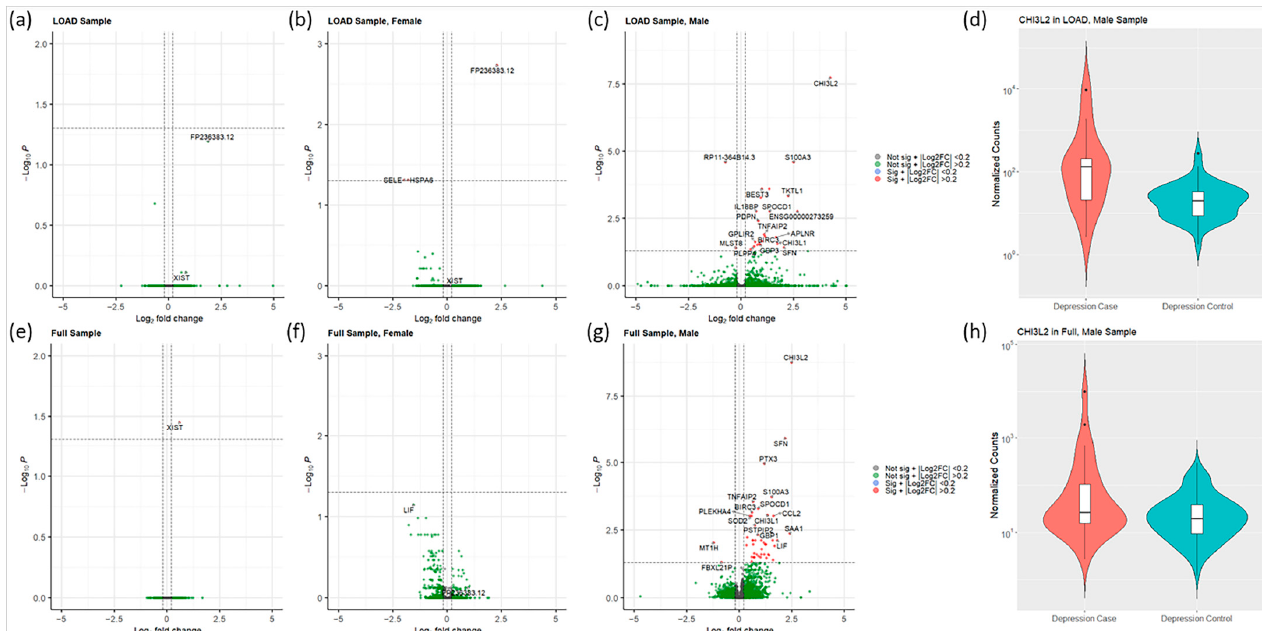
Figure 1. Differential gene expression analysis identified sex-specific expression in depression. Vol- cano plots of the ( a ) LOAD sample, ( b ) female subset of LOAD sample, and ( c ) male subset of LOAD sample. There were no DEGs in the LOAD sample, while the sex-stratified analysis detected 3 and 25 DEGs within the female and male samples, respectively. ( d ) CHI3L2 was significantly upregu- lated within the male, LOAD sample illustrated by the violin plot (log 2 FC = 4.248, p = 1.84 × 10 − 8 ). Volcano plots of the ( e ) full sample, ( f ) female subset of full sample, and ( g ) male subset of full sample. XIST was significantly upregulated in the full sample (log 2 FC = 0.594, p = 0.035), while the sex-stratified analysis demonstrated no DEGs in the female sample while the male sample had 44 DEGs. ( h ) CHI32 was upregulated in the full, male sample demonstrated by the violin plot (log 2 FC = 2.481, p = 1.74 × 10 − 9 ). Adjusted p -value cutoff of 0.05 and Log 2 FC cutoff of 0.2 was used for the volcano